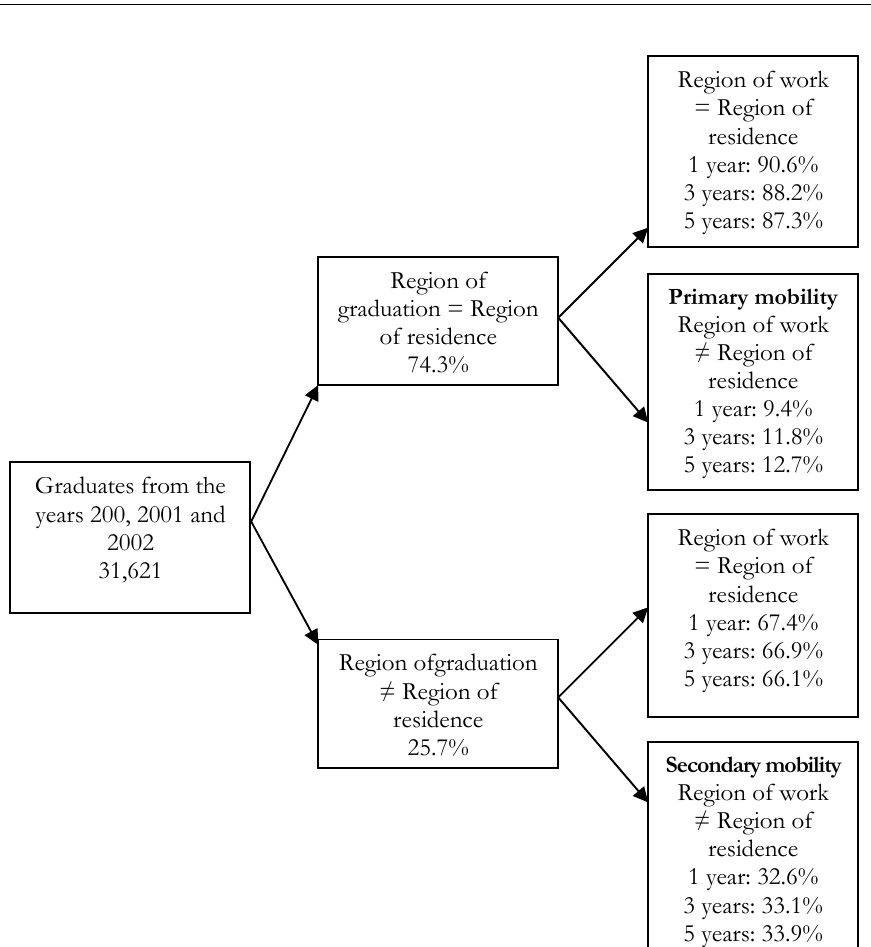
Figure 2 – Graduates from the years 2000, 2001 and 2002: mobility for study and occupational rea- sons at one, three and five years from graduation. Note: the percentages relating to the comparison between region of work and region of residence are calculated on the employed graduates only and not on the total number of interviewees as is the case, instead, of the percentages relating to the comparison between region of graduation and re- gion of